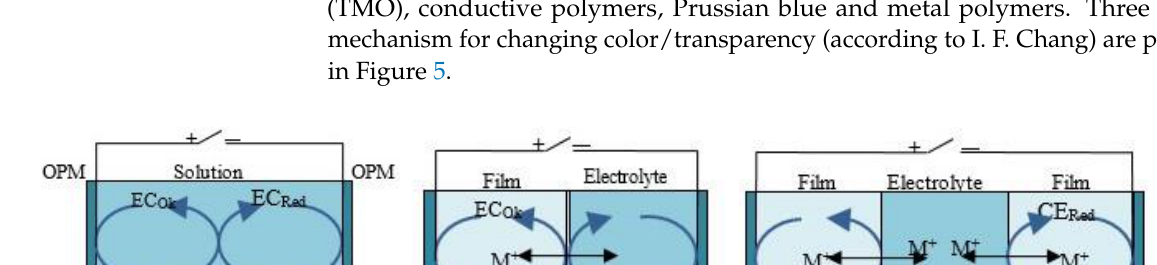
Type III EC materials are solids in both redox states, and they form an insoluble film on the electrode surface. Type III materials include groups IV, V transition metal oxides